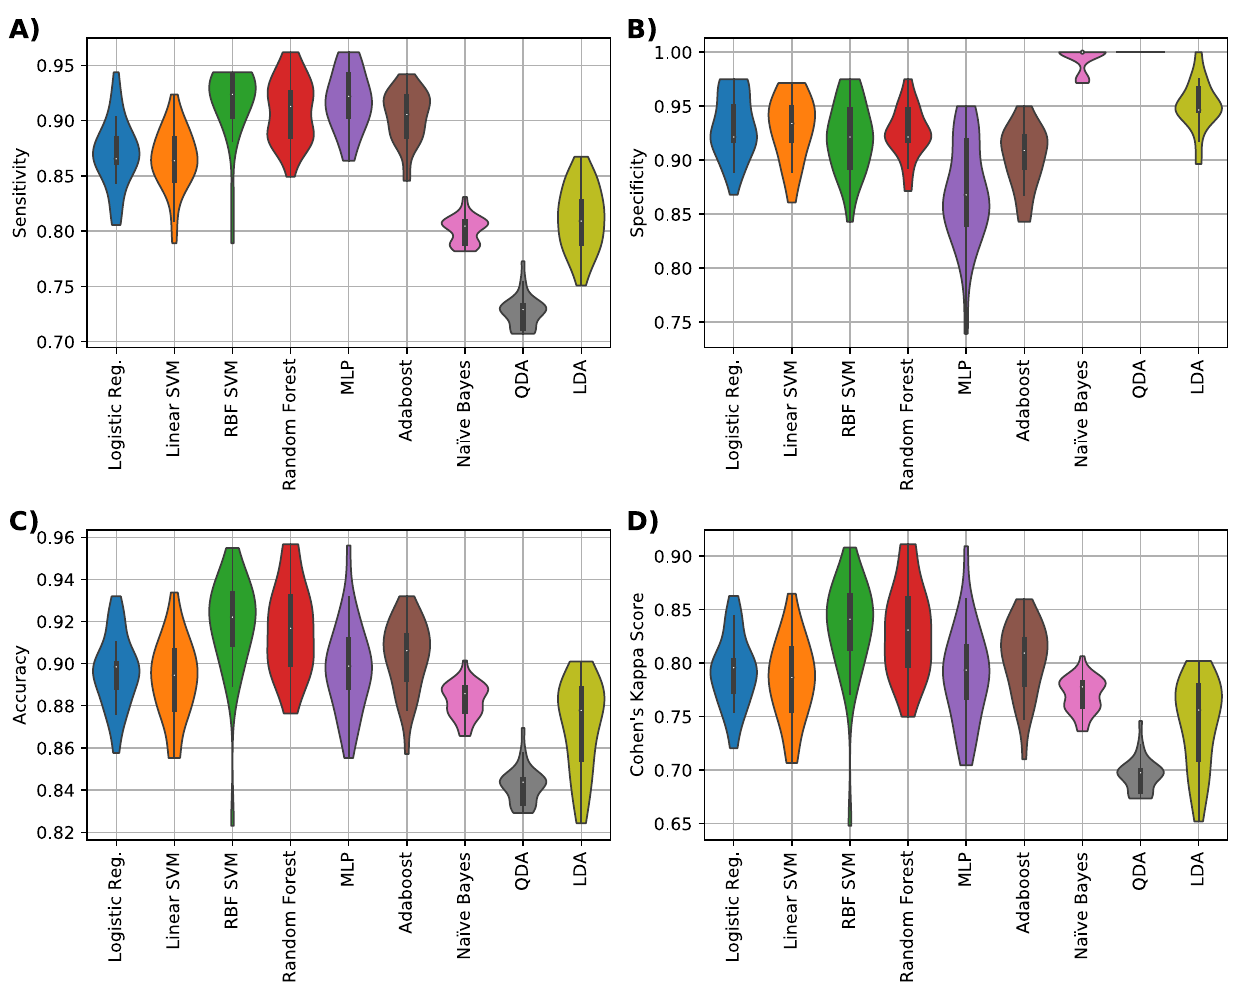
Figure 4. Performance metrics results for the data set composed with the binning features and the three external features. ( A ) Sensitivity, ( B ) Specificity, ( C ) Accuracy and ( D ) Cohen’s kappa values of nine different